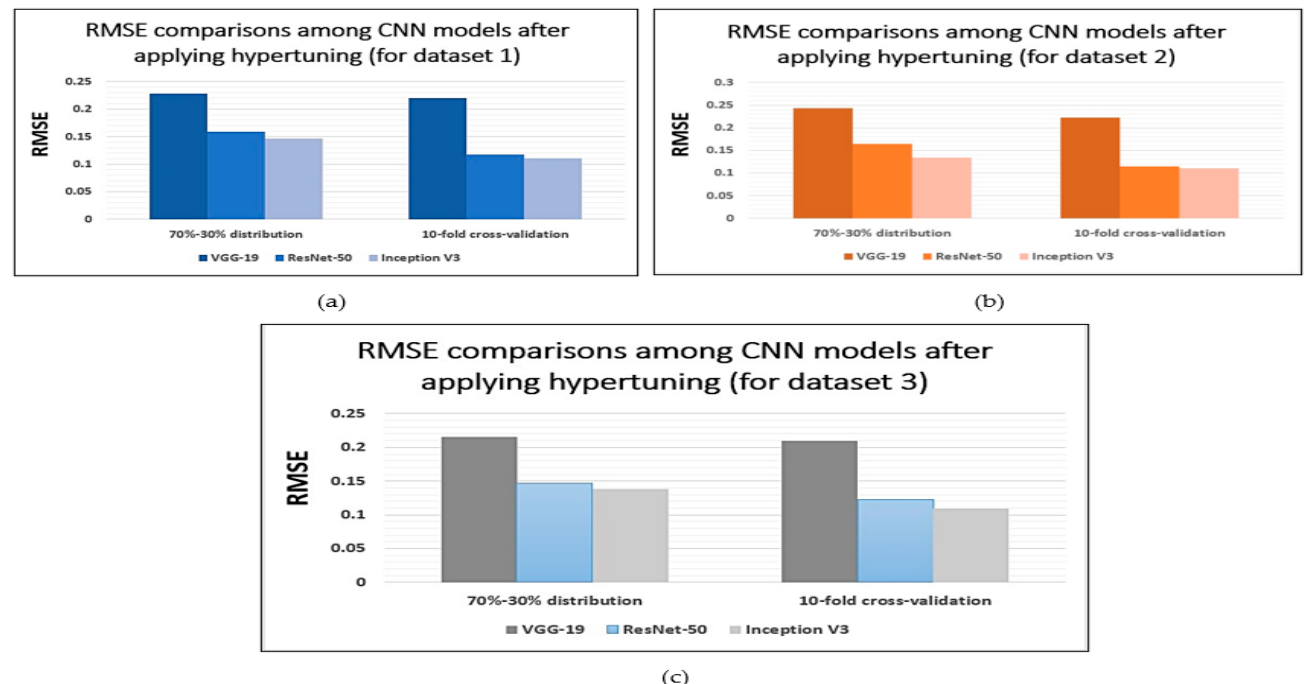
Figure 8. Comparison among VGG-19, ResNet-50, and Inception V3 in terms of RMSE for ( a ) dataset 1, ( b ) dataset 2, and ( c ) dataset 3.